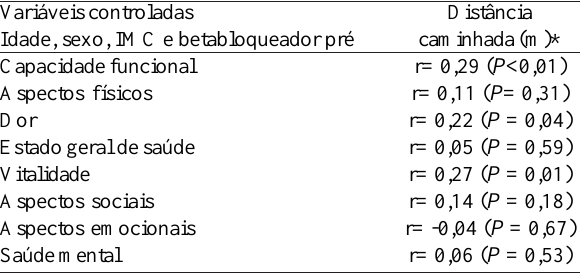
Tabela 5. Correlação do teste de caminhada vs. questionário SF- 36 no pós-operatório.